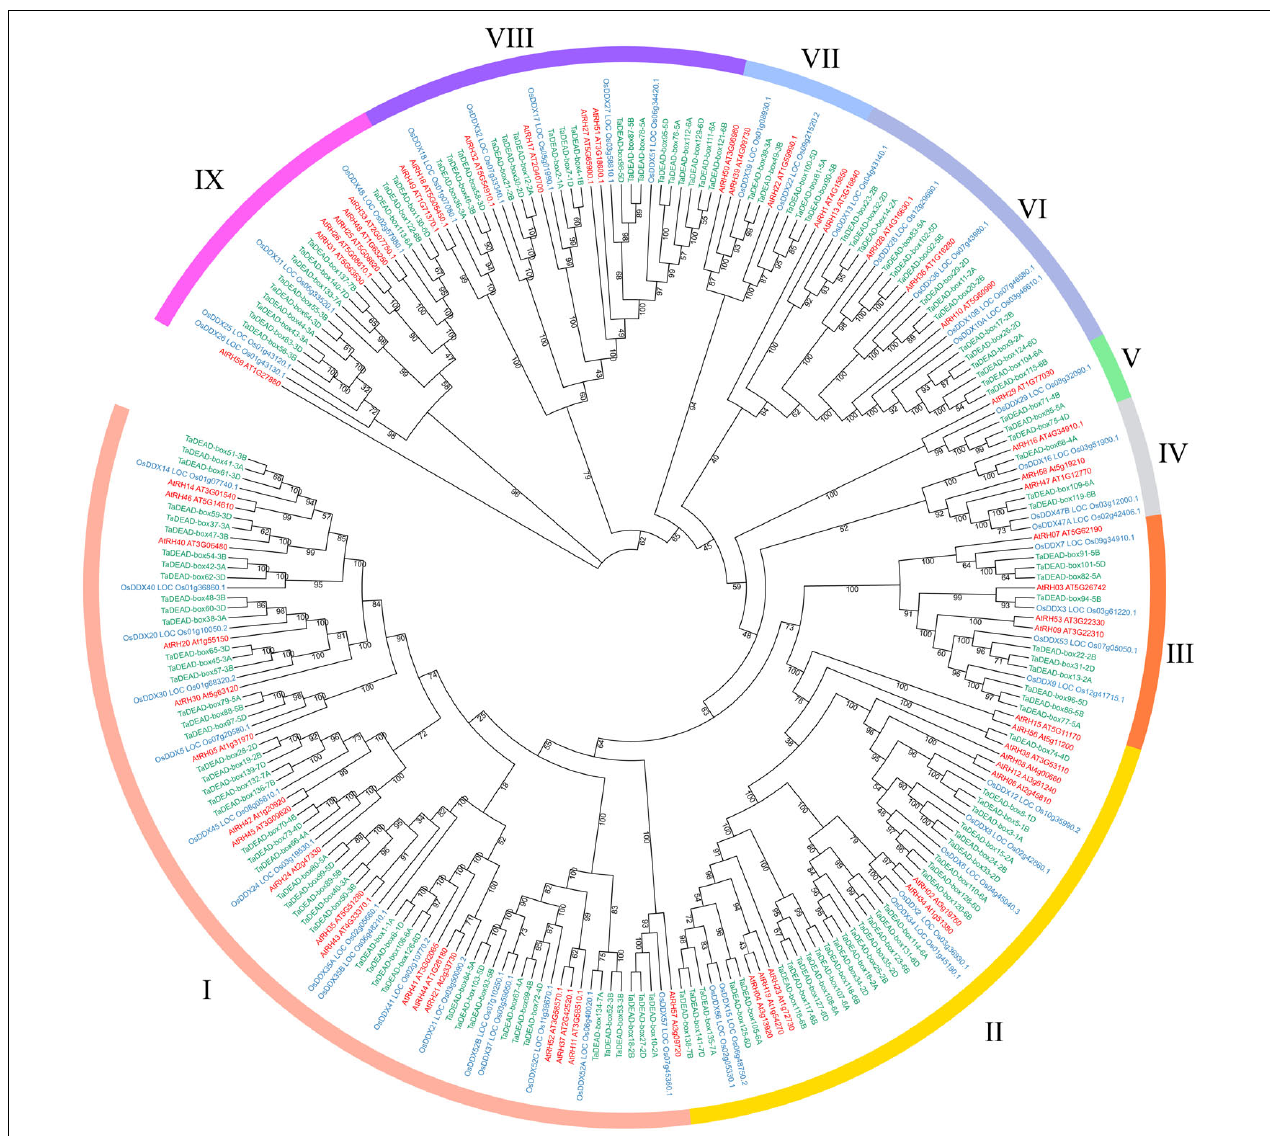
FIGURE 1 | Phylogenetic analysis of DEAD-box proteins in wheat, rice and Arabidopsis . A total of 245 proteins were used to construct the maximum-likelihood (ML) phylogenetic tree by MEGA X with 1,000 bootstrap replicates. The DEAD-box proteins were divided into nine groups (I-IX), which were marked with different colors. The members of three species were, respectively, marked with different colors: red for Arabidopsis , blue for rice, and green for wheat.